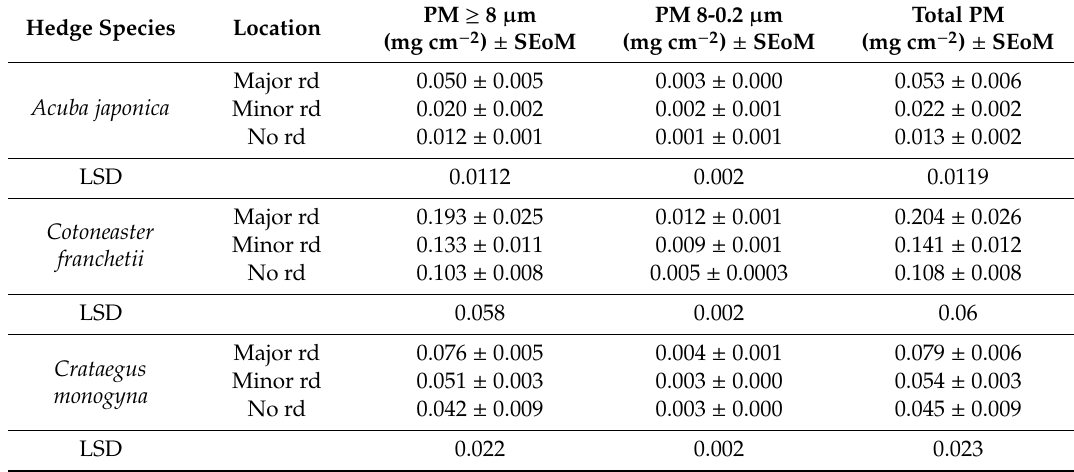
Table 5. Mean particulate matter mass (in class sizes ≥ 8 µ m, 8-0.2 µ m and total) per leaf area (mg cm − 2 ) of Aucuba japonica , Cotoneaster franchetii and Crataegus monogyna at sites with di ff erent tra ffi c intensities. Data points are mean values of three samples, with associated Standard Errors of the Mean (SEoM) and Least Significant Di ff erence (LSD) of the